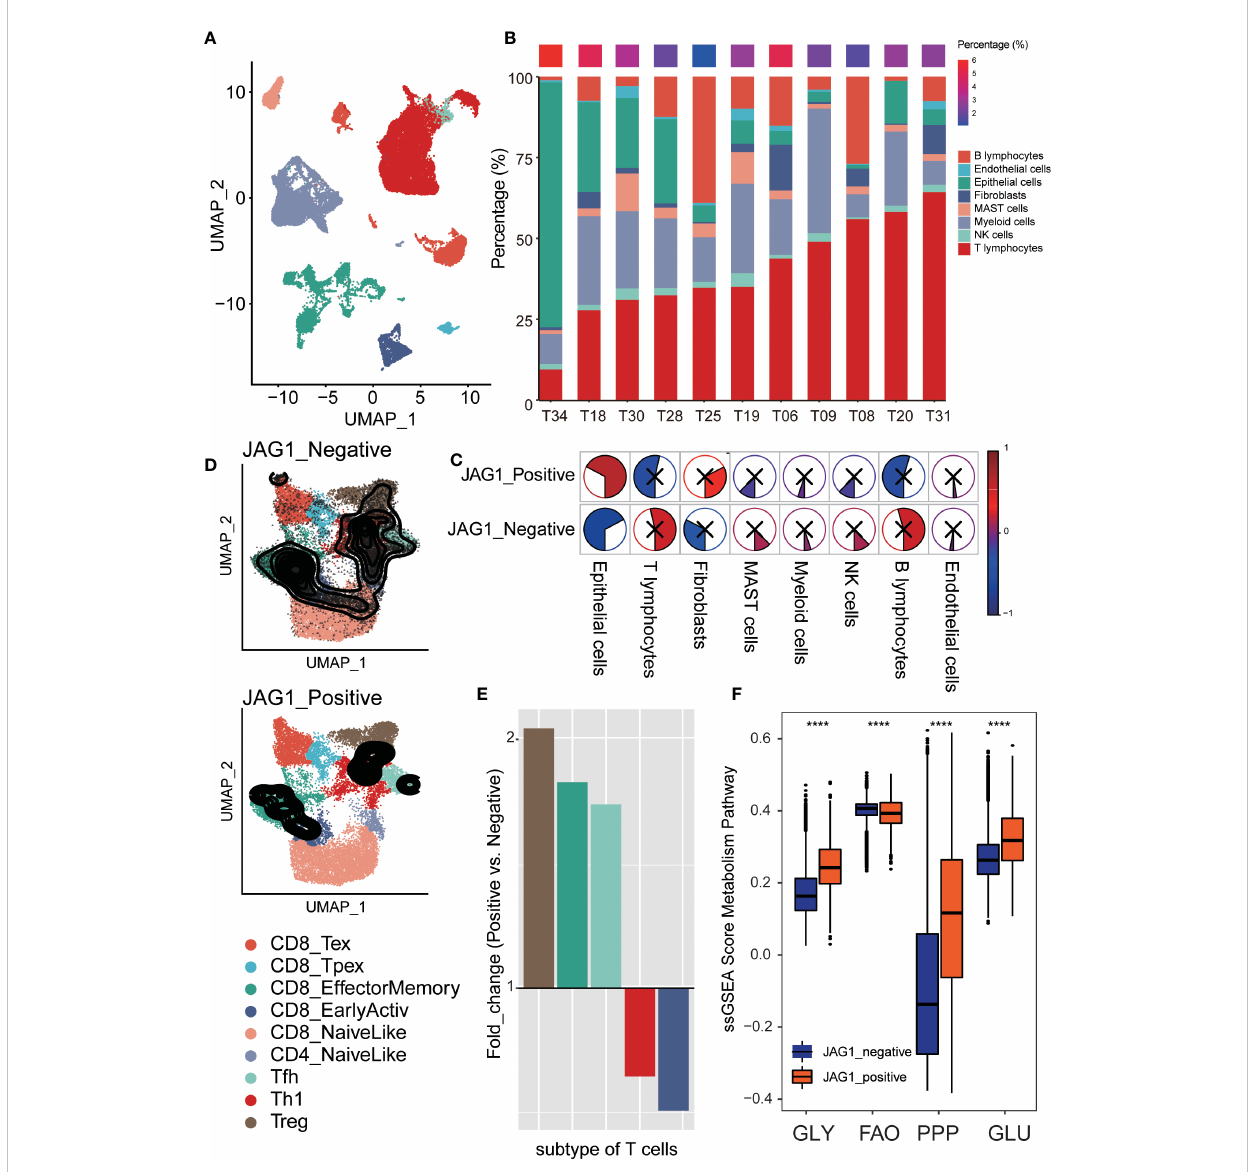
FIGURE 6 Comparison of Treg proportion between JGA1+ and JAG- cells in single-cell level. (A) The TSNE clustering visualization of single-cell RNA sequencing of lung adenocarcinoma colored by cell types. (B) The composition ratio of each cell type per sample. The percentage of JAG+ cells was showed above colored from blue (low) to red (high). (C) The pie plot showed the correlation of JGA1+ cell proportion and each cell type ’ s composition ratio. Colors represented correlation coef fi cients, blue for negative and red for positive correlations. And, the sector area also represented the correlation. P < 0.05 was considered signi fi cant, and those that were not signi fi cant were marked with X. (D) The tSNE plot of T cells colored by subtype and divided into two groups based on JAG1 expression: JAG1 + and JAG1 - group. (E) The fold change of T cell subset composition of positive and negative cells. (F) The comparison of metabolism pathway activation between JAG1 + and JAG1 - cells. *, P < 0.05; **, P < 0.01; ***, P < 0.001; ****, P <